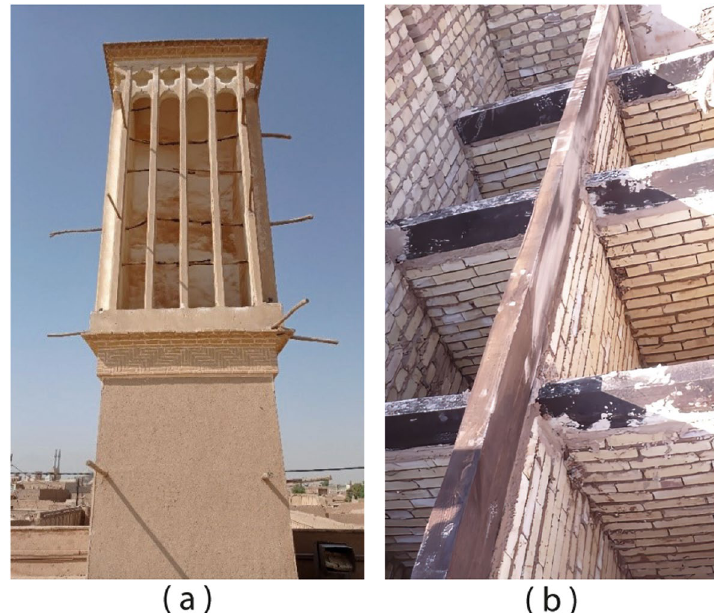
Fig. 26 Using timber elements in wind‑catchers in Yazd: ( a ) upon the external walls, the Lariha house (Source: the authors) and ( b ) upon the internal walls (Source: Ehasn Raad, during reconstruction work on the Navab‑vakil